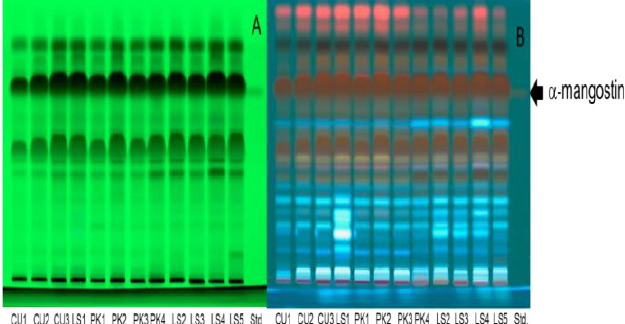
Figure 4: Phytochemical fingerprint of the mangosteen pericarp methanol extracts. A: the fingerprint under 254 nm UV-transluminescent, B: the fingerprint under 366 nm UV-transluminescent. CU1, CU2, and CU3 are the samples collected from Cha-Uat district, LS1, LS2, LS3, LS4, and